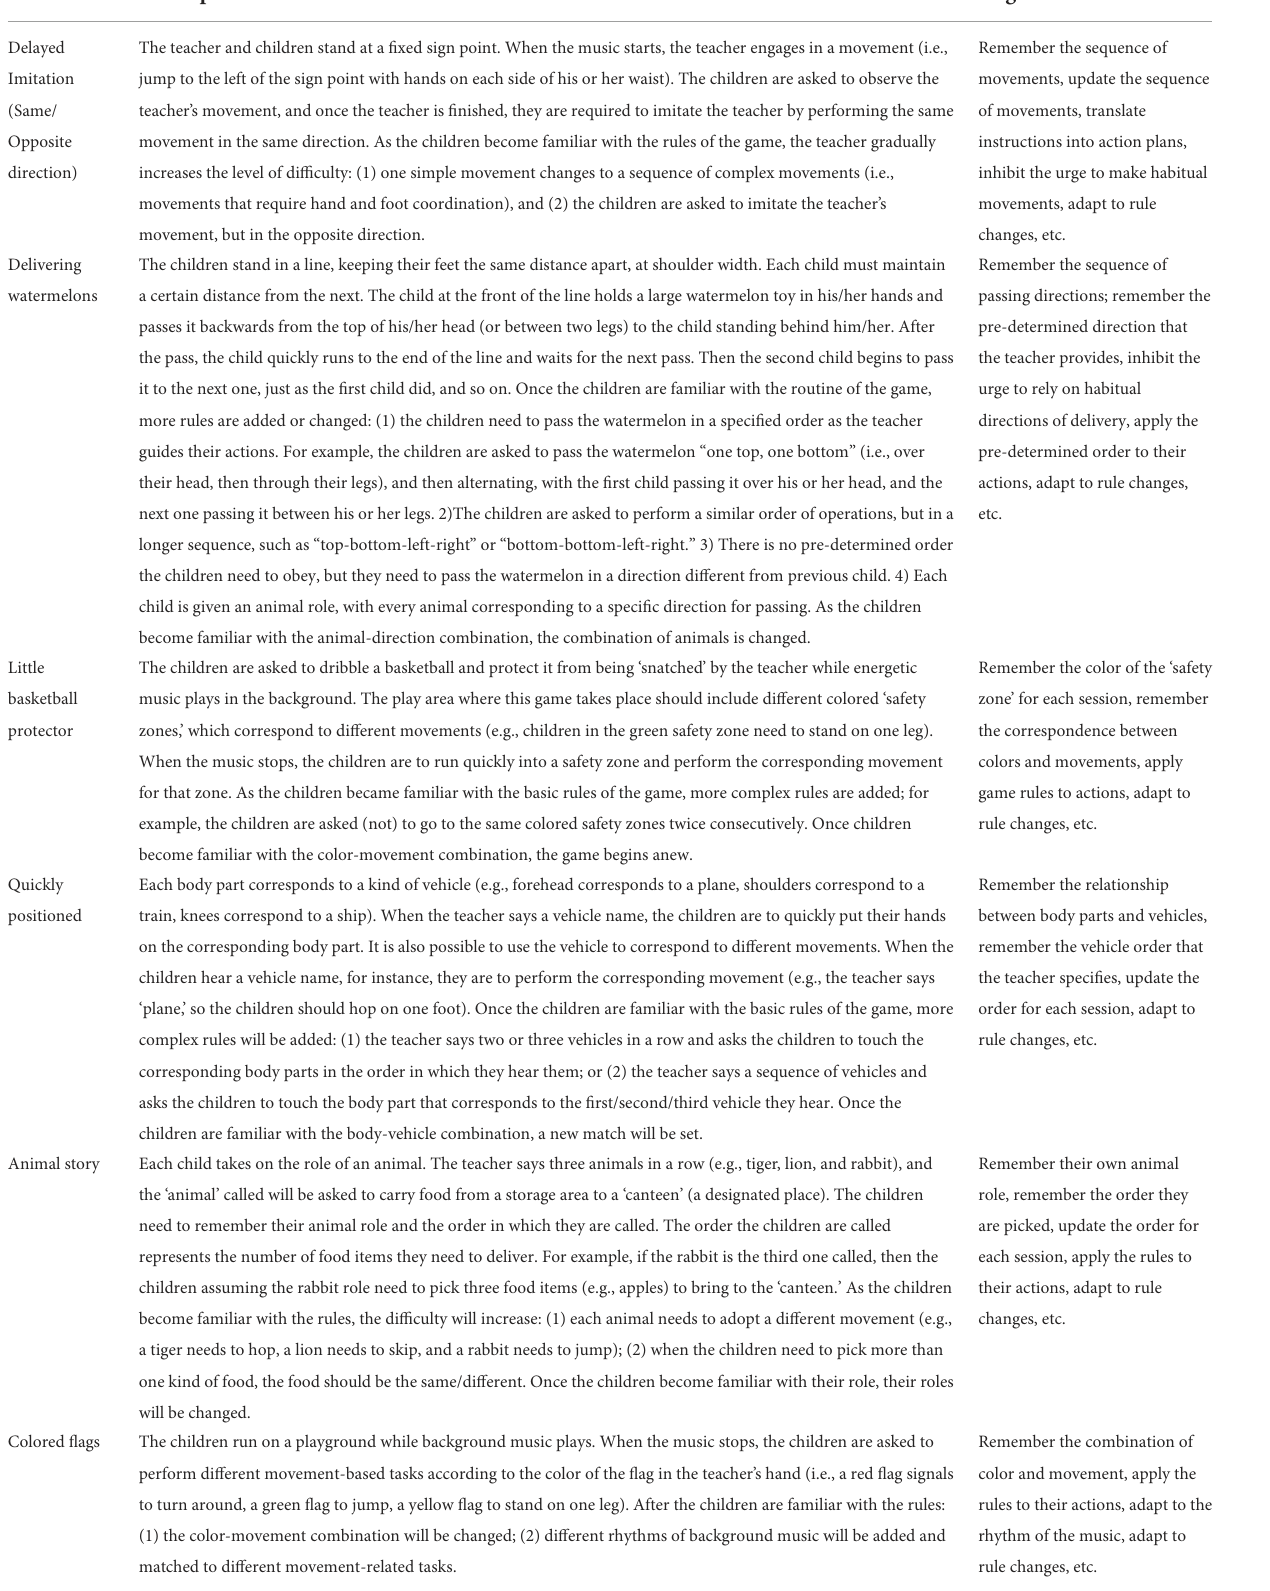
TABLE 2 Summary of six main type 2 games in the physical activity